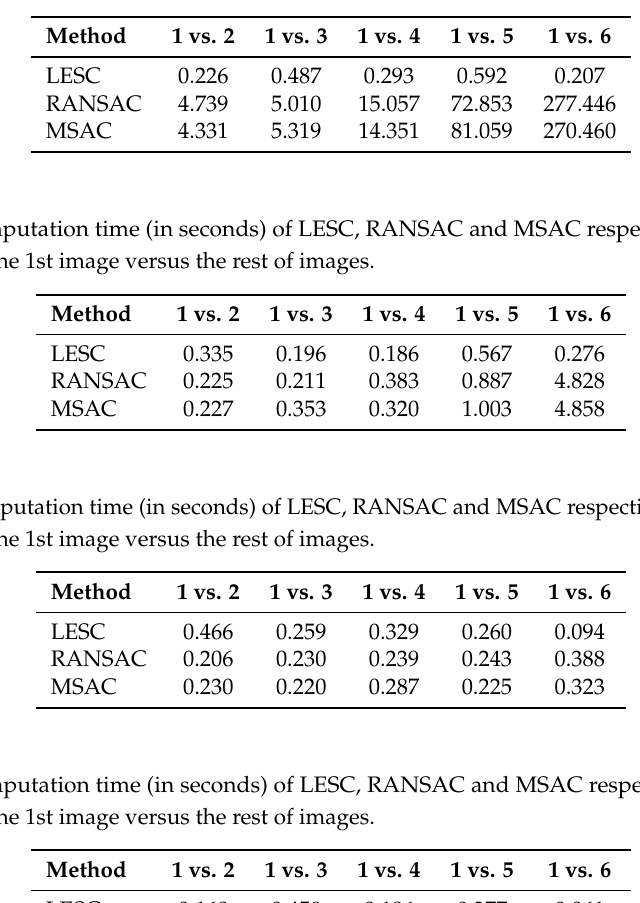
Table 6. The computation time (in seconds) of LESC, RANSAC and MSAC respectively on the Trees sequence using the 1st image versus the rest of images.